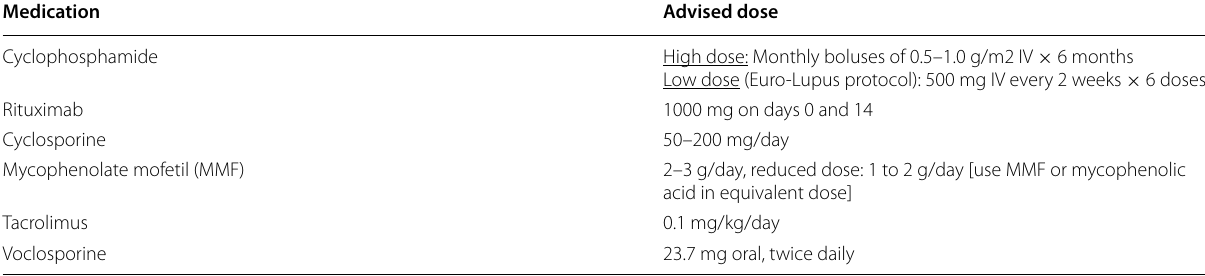
Table 2 List of medication and their advised doses which are recommended for induction therapy (class III/IV) lupus nephritis